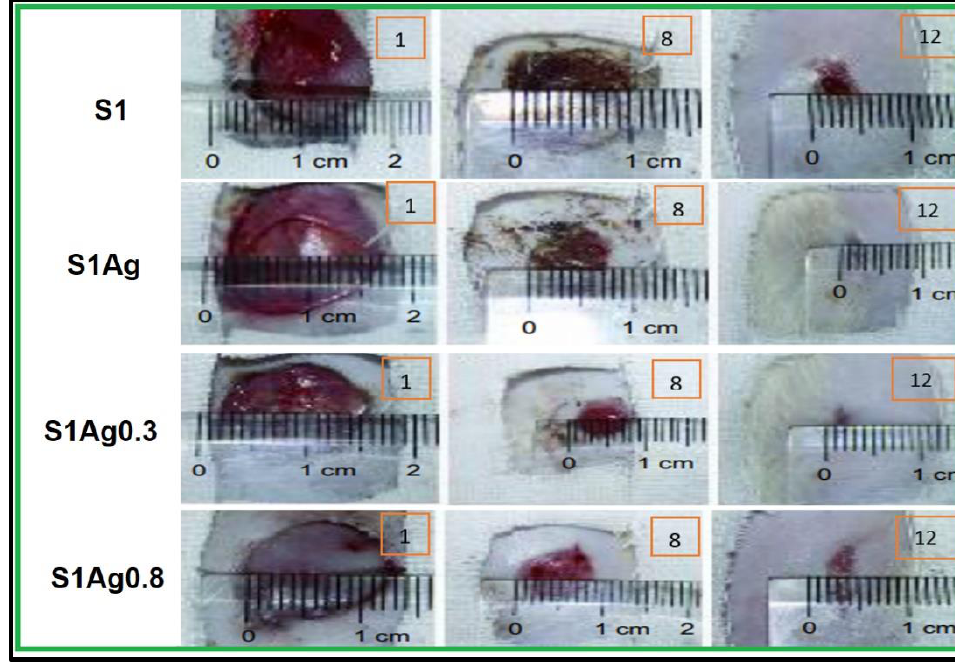
Figure 6. Wound size reduction rate at 1, 8, and 12 days after grafting with the four samples.